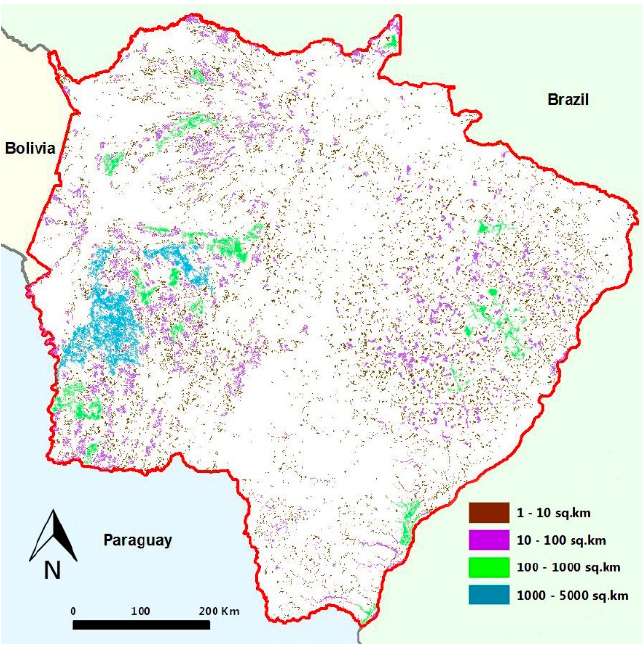
Figure 2. Patch size variation in the Cerrado landscape ranging from 1–5000 km 2 .